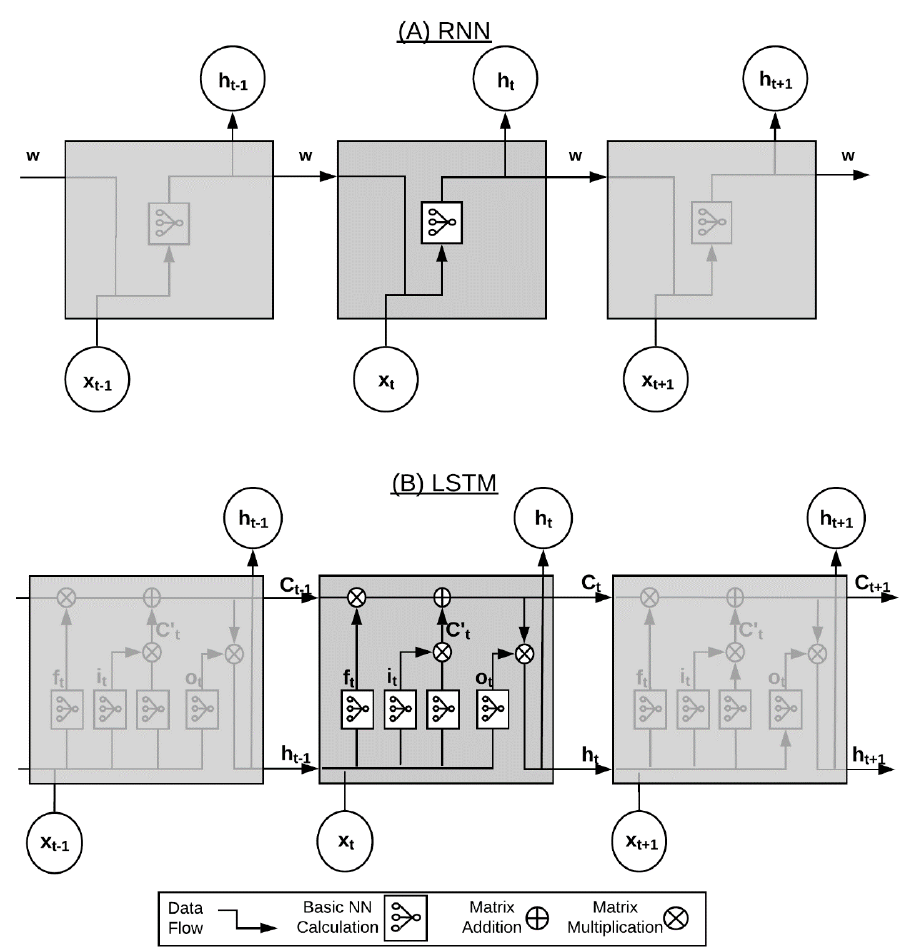
Figure 4. Recurrent neural network (RNN) ( A ) and long short-term memory (LSTM) ( B ) model architectures. Merging lines show concatenation and splitting lines represent copies of matrices being sent to different locations.